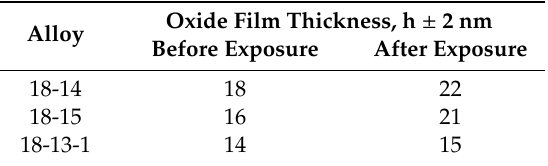
Figure 3. Oxygen concentration depth profiles for the 18-14, 18-15, and 18-13-1 alloys before and after exposure to Hanks’ solution for 604.8 ks. Table 5. Oxide film thicknesses estimated for the 18-14, 18-15, and 18-13-1 alloys before and after exposure to Hanks’ solution.